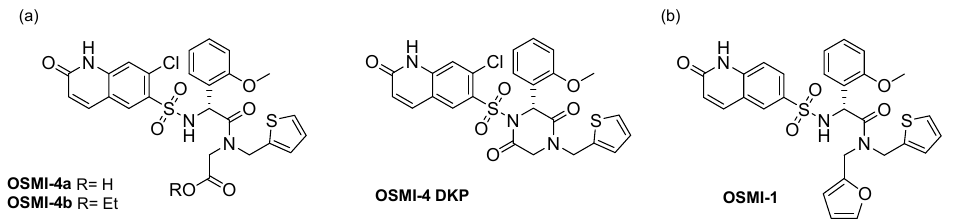
Figure 2. ( a ) Structure of OSMI-4a (carboxylic acid), OSMI-4b (ethyl ester), and the corresponding diketopiperazine derivative, OSMI-4 DKP; ( b ) structure of OGT inhibitor OSMI-1.